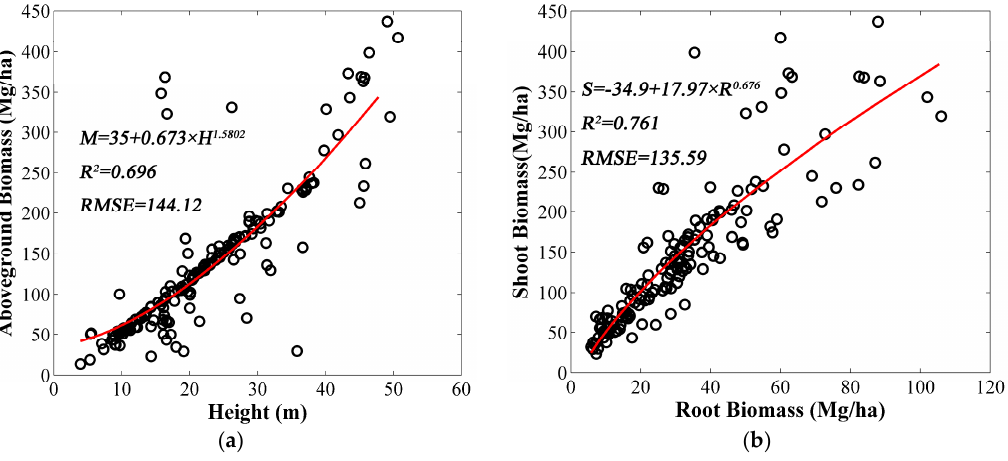
Figure 3. The allometric relationships of forest tree heights, aboveground biomass and root biomass. ( a ) The allometric relationship between field aboveground biomass and height; and ( b ) the allometric relationship between the field aboveground biomass and root biomass.